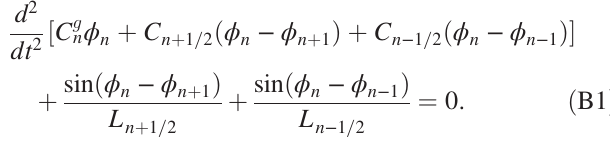
ffiffiffiffiffiffiffiffi p ¯ ¯ L C and the ffiffiffiffiffiffiffiffiffiffiffi p ¯ ¯ ¼ C= C g . Assuming s